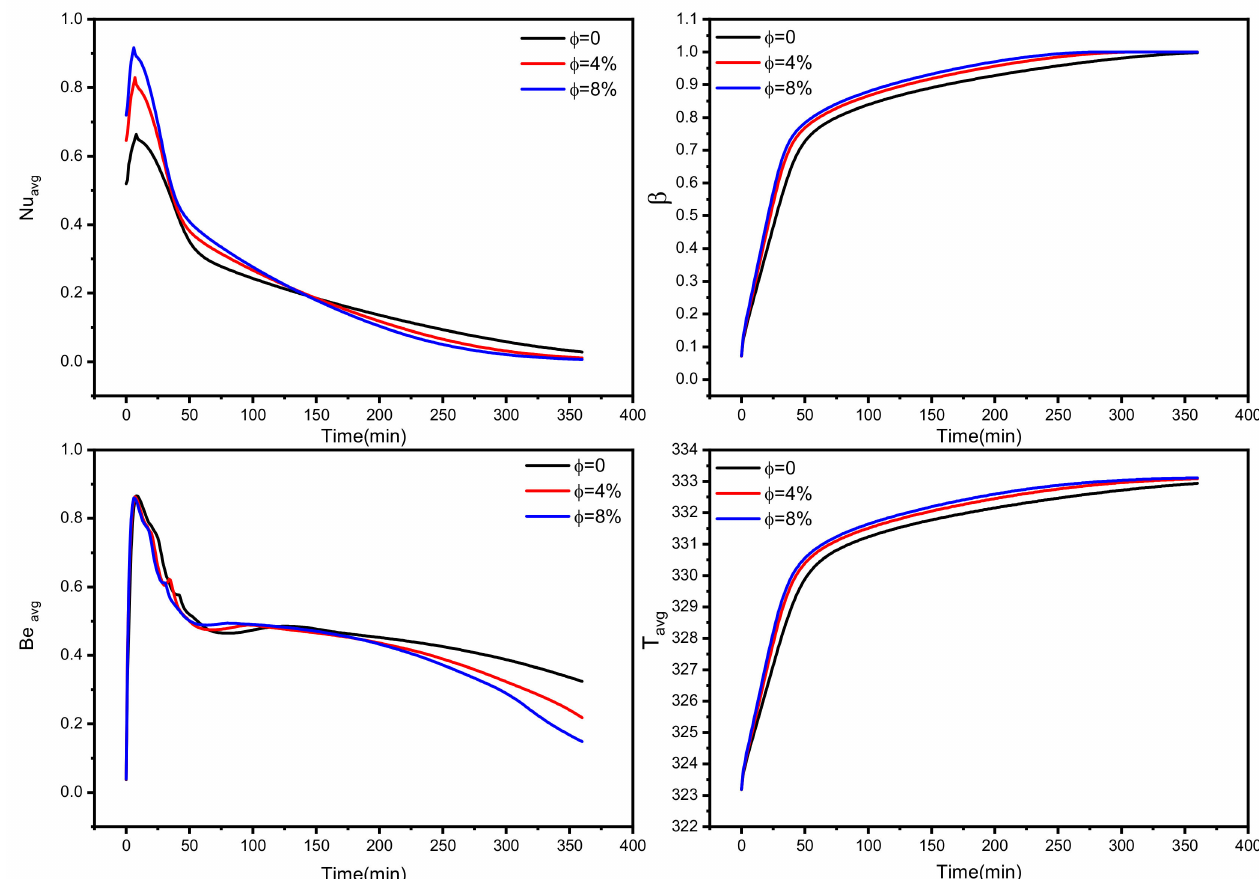
Figure 8. The temporal effect of nanoparticle concentration on the investigated tube-shell TES performance is the average Nusselt number, liquid fraction, average Bejan number, and average PCM